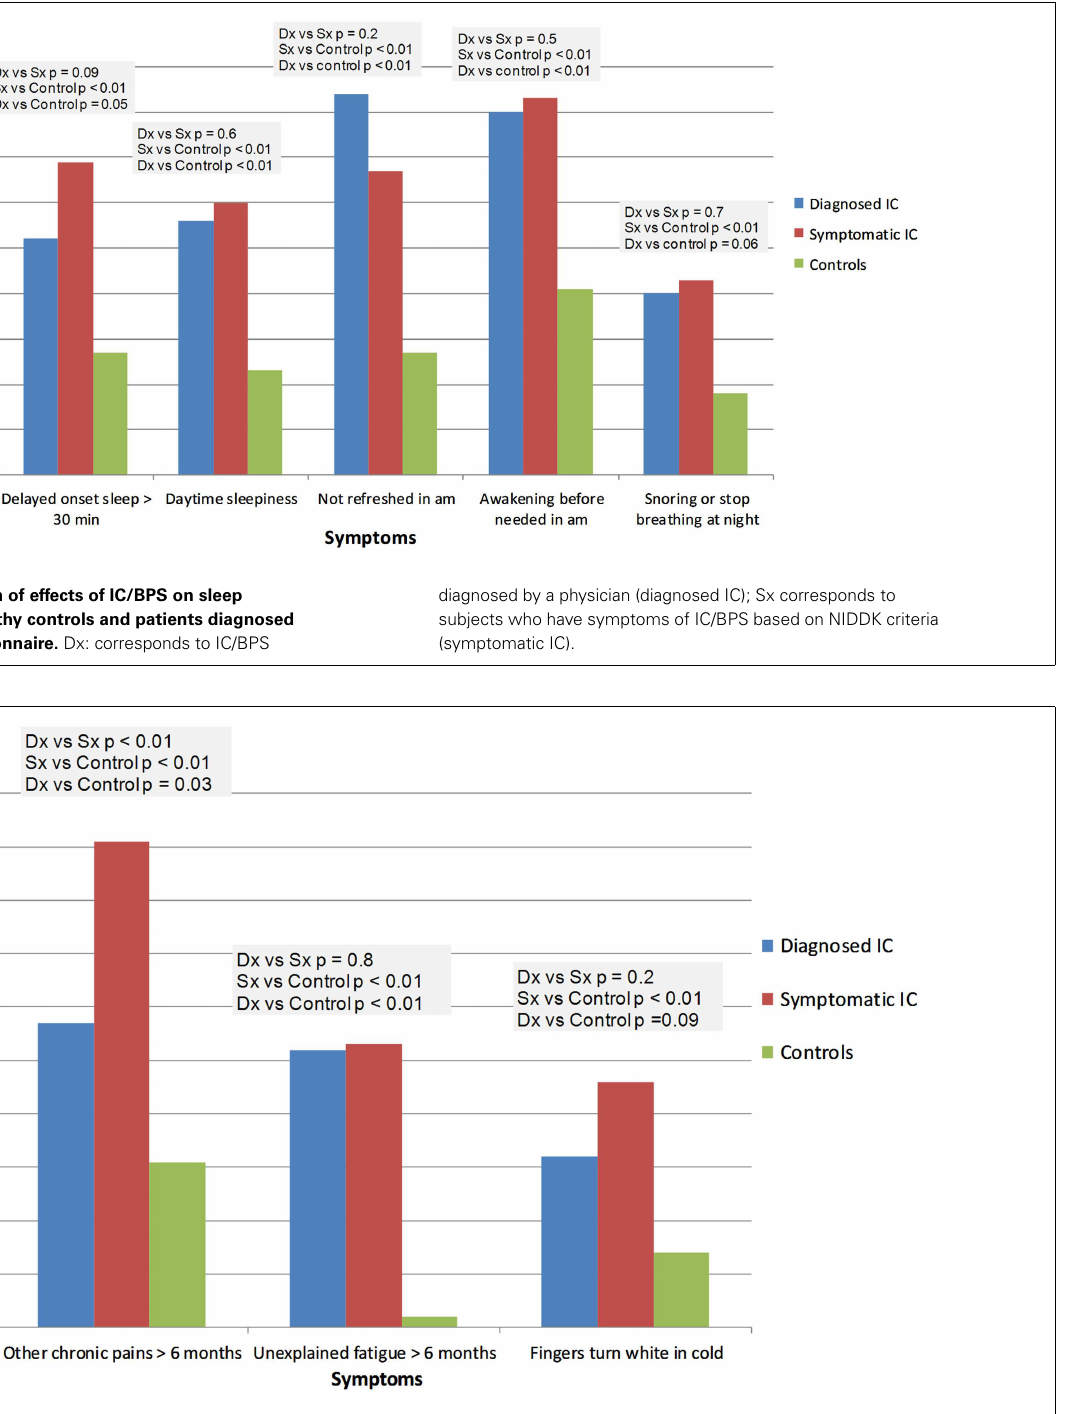
FIGURE 2 |This figure summarizes the complaints of fatigue, chronic pains, and Raynaud’s like symptoms. Dx: corresponds to IC/BPS